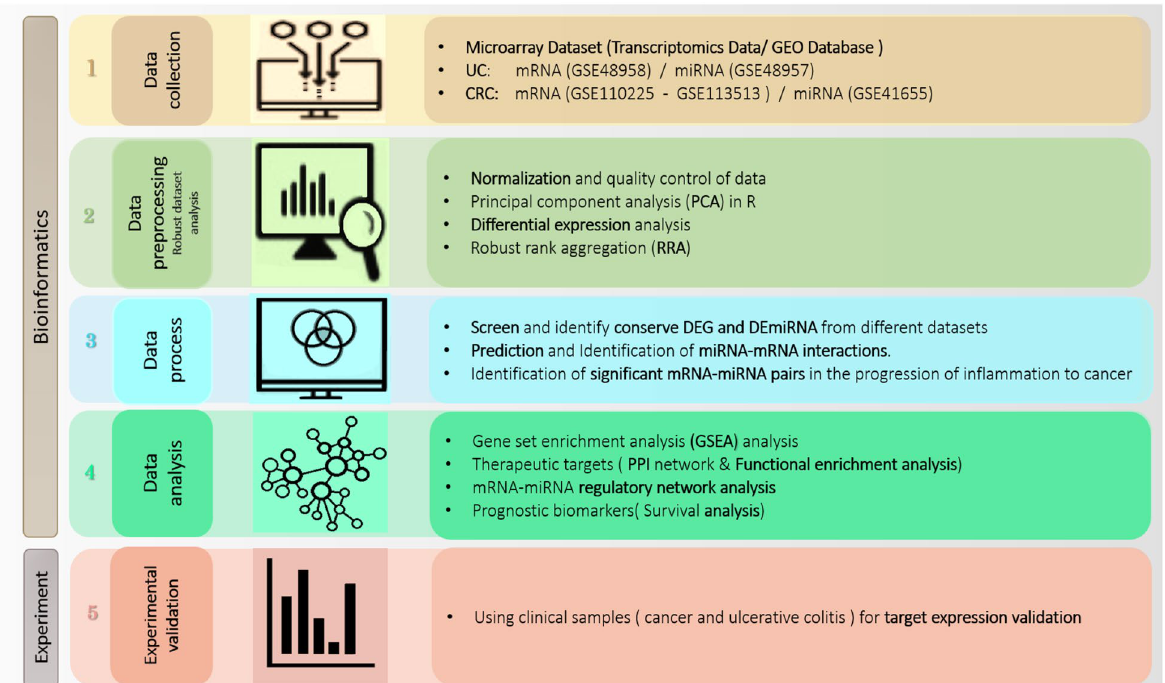
Figure 1. Five sets of microarray data were downloaded and analyzed for differential identification. mRNAs, miRNAs are expressed in UC, CRC and normal tissues. By performing normalization and quality control,